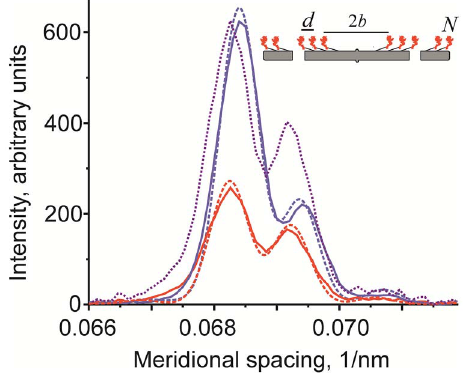
Figure 6. M3 profiles during isometric contraction (blue continuous line) and stretch (red continuous line) in the second series of experiments with a long x-ray camera averaged over two halves of the patterns and 32 runs of the protocol in three fiber bundles. The M3 profile during stretch scaled to equalize its low-angle peak with that measured during isometric contraction is shown by the dotted magenta line. Results of the modeling of the M3 meridional profile using the point diffractor model [15] with a half-bare zone length b , with the distance between crowns of myosin heads d and the total number of crowns N =50 in each half of a thick filament: b =74.75 nm and d =14.564 nm that provide the best fit to the isometric data (blue dashed line) and b =75.8 nm, d =14.569 nm giving the best fit to the data obtained during stretch (red dashed line). The calculated profiles were then convoluted with a Gaussian point spread function with the standard deviation of 2.26 nm 2 1 .